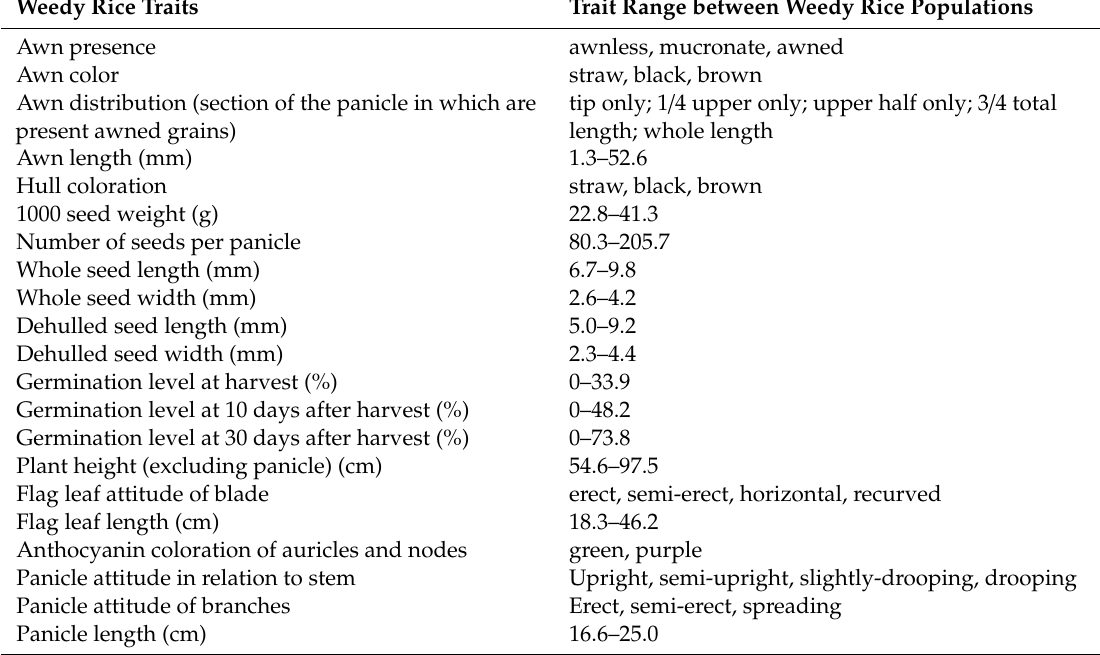
Table 1. Weedy rice trait variability (range) between 150 weedy rice populations collected in Italy (modified from Fogliatto et al.,